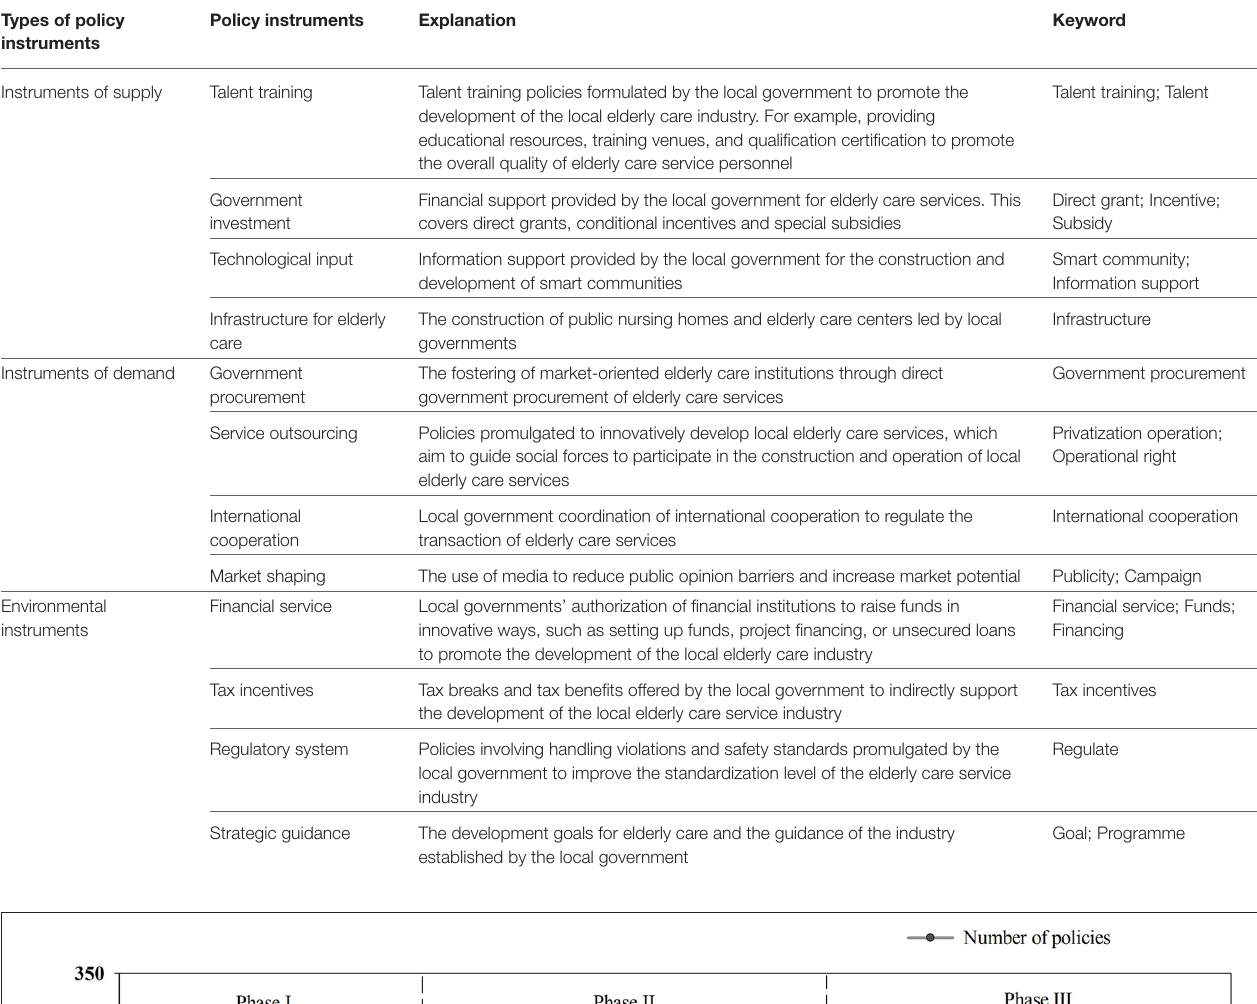
TABLE 1 | Classification framework of policy instruments.